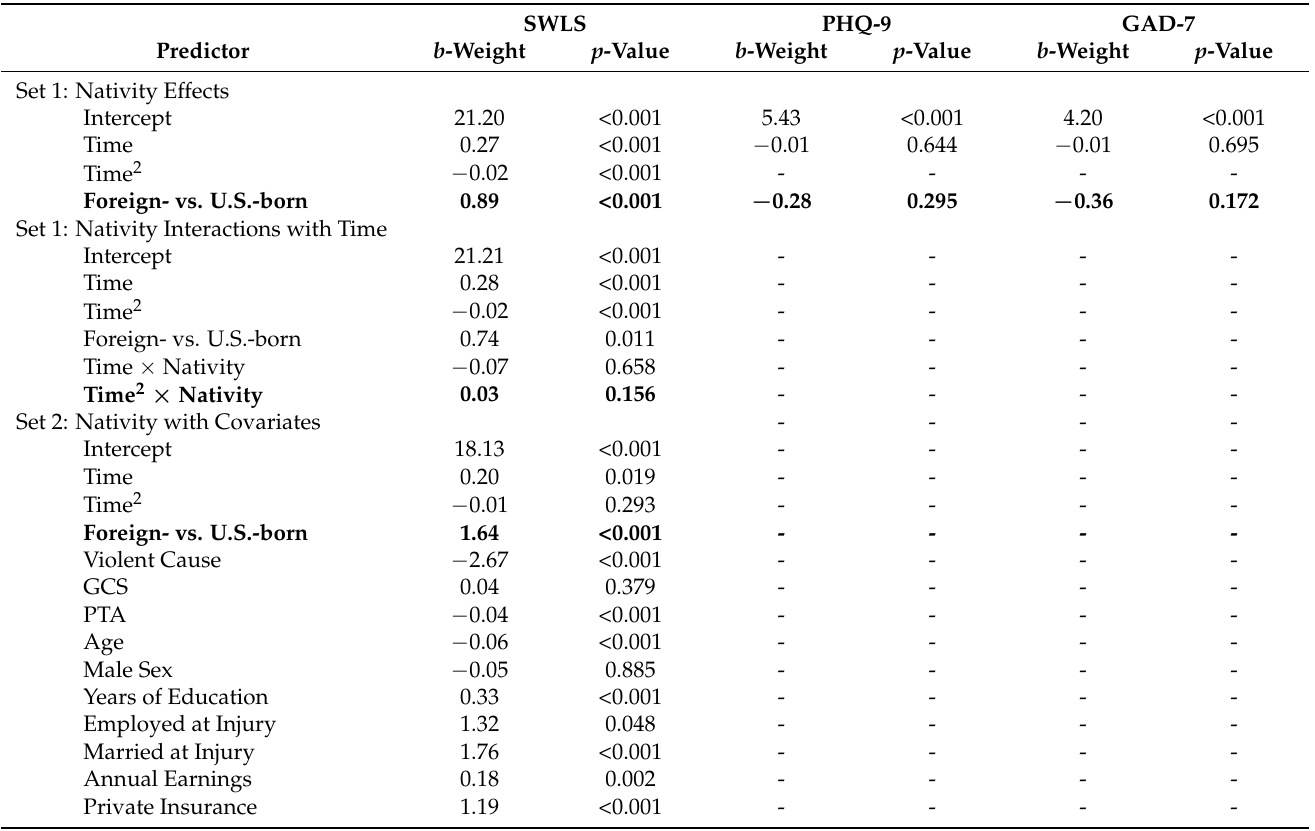
Table 4. Predictors of SWLS, PHQ-9, and GAD-7 trajectories. SWLS